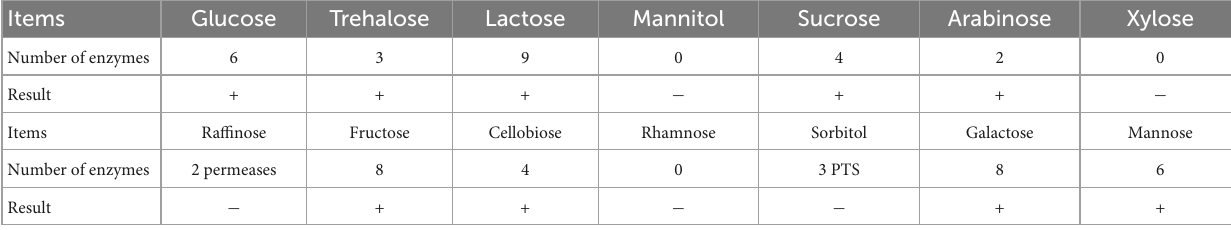
TABLE 5 Prediction of sugar source utilization capacity of MC5 and number of key enzymes that metabolize the sugar based on KEGG database annotation results (number of enzymes).